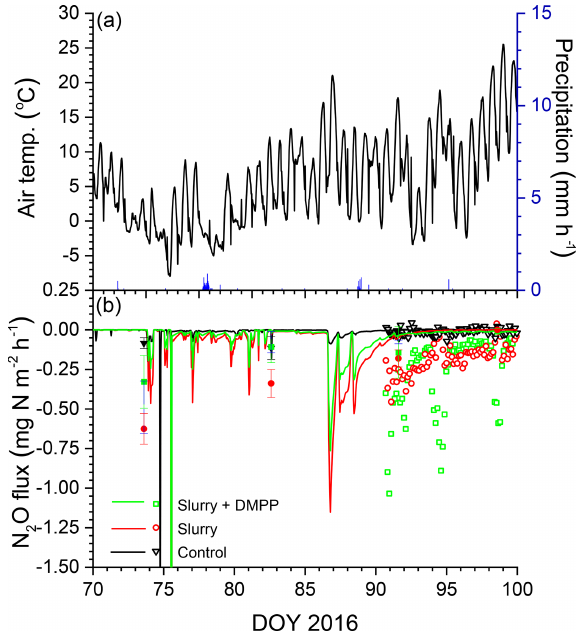
Figure 4. (a) Air temperature and precipitation and (b) N 2 O fluxes measured (symbols) and modelled (lines) during early spring 2015 with no slurry (control) and following slurry application on DOY 273 in 2014 with or without DMPP. Filled symbols represent manual chamber measurements by Lin et al. (2018). Negative val- ues denote emissions.